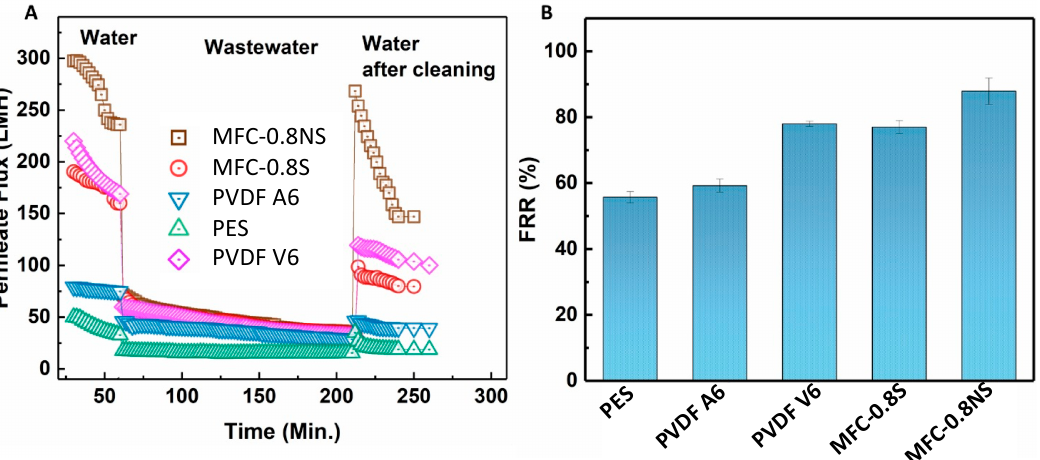
Figure 12. ( A ) Permeate flux for the fouling test and ( B ) flux recovery ratio (FRR) results for MFC- based and commercial membranes.